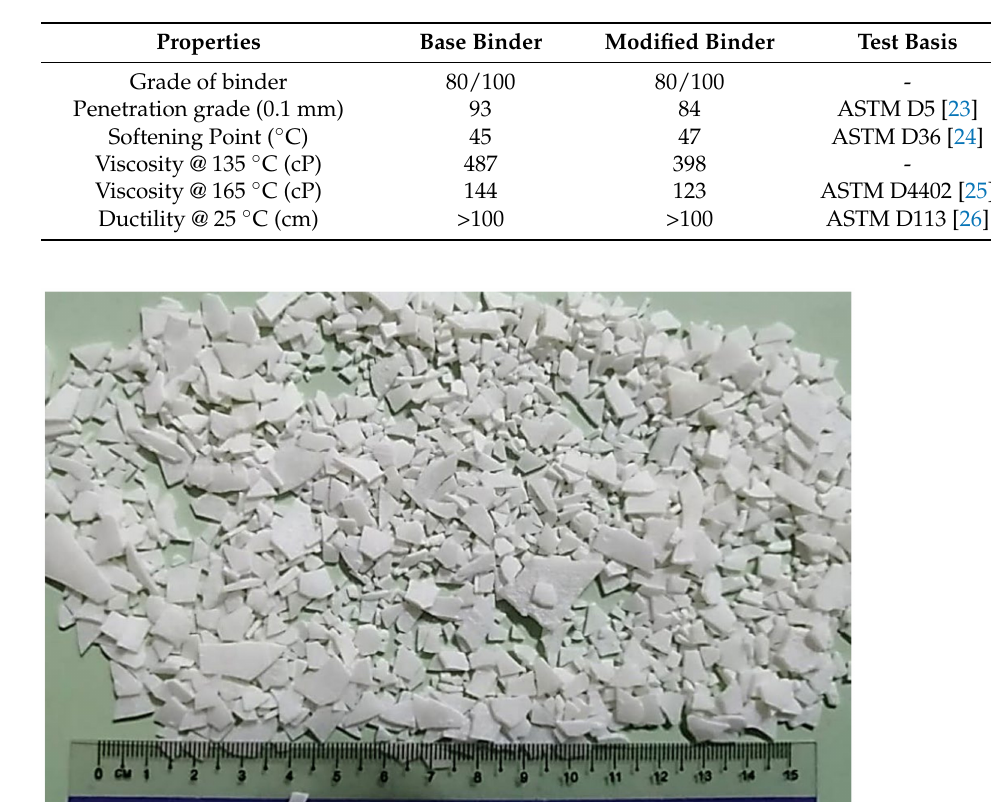
Table 1. Characteristics of the base and modified binders.